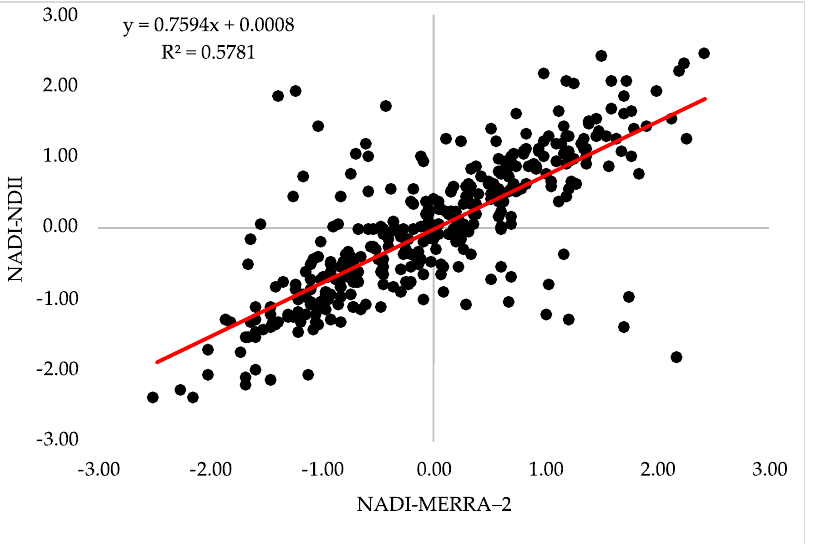
Figure 5. Correlation between NADI-NDII and NADI-MERRA–2 over the Luvuvhu River Catchment between 1986 and 2016.